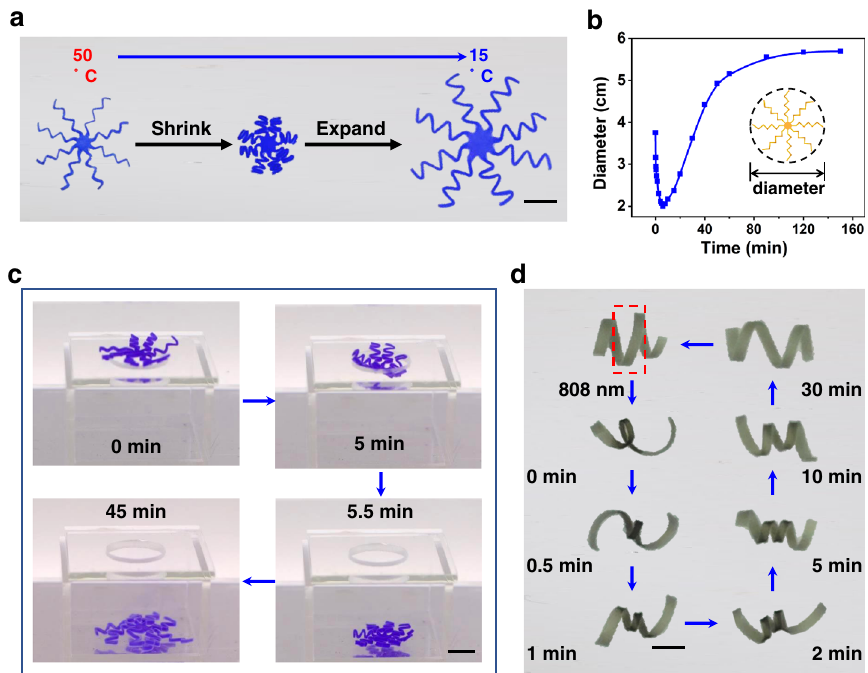
Fig. 4 Demonstration of an eight-arm FFE shape-shifting device. a Top view of the shrinking and subsequent expansion upon cooling. Scale bar: 1.0 cm. b Quantitative time evolution of the device diameter. c Dual opposite actions enabling the device to pass through the small hole. Scale bar: 1.0 cm. d Light triggered spatial actuation and the subsequent FFE transformation. The sample in cool water was exposed by near IR light (808 nm) at the framed location for 20 s. Subsequent photos at different times show the FFE behavior. Scale bar: 0.5